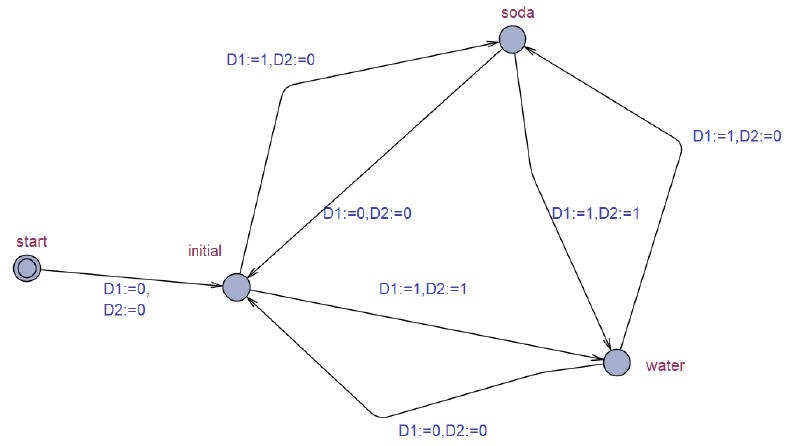
Figure 12. UPPAAL timed automata model of the conveyor band.